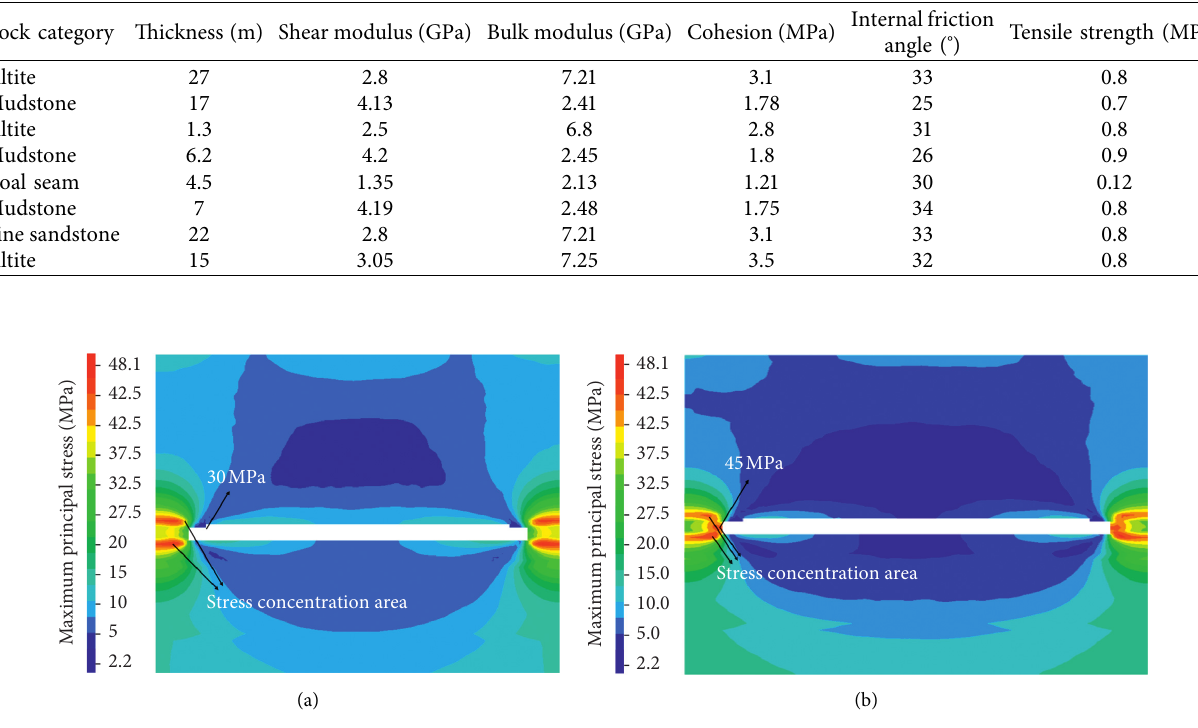
Figure 5: Section nephogram of maximum principal stress profile of different support types. (a) Single hydraulic prop support. (b) Anchor cable